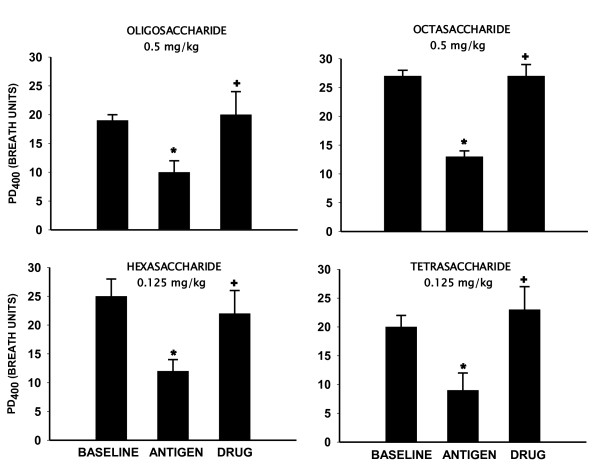
Effect of inhaled heparin oligosaccharides on antigen-induced airway hyperresponsiveness (AHR) in "Dual Responder" sheep. Data are shown as PD400 (cumulative provocating dose of carbachol in breath units which increased SRL by 400%) ± SE for the baseline, and 24 hours post-antigen, without and after pretreatment with oligosaccharide mixture (0.5 mg/kg) and various fractions including Octasaccharide (0.5 mg/kg), hexasaccharide (0.125 mg/kg) and tetrasaccharide (0.125 mg/kg). * Significantly different from baseline (P < .05). + Significantly different from antigen control (P < .05).